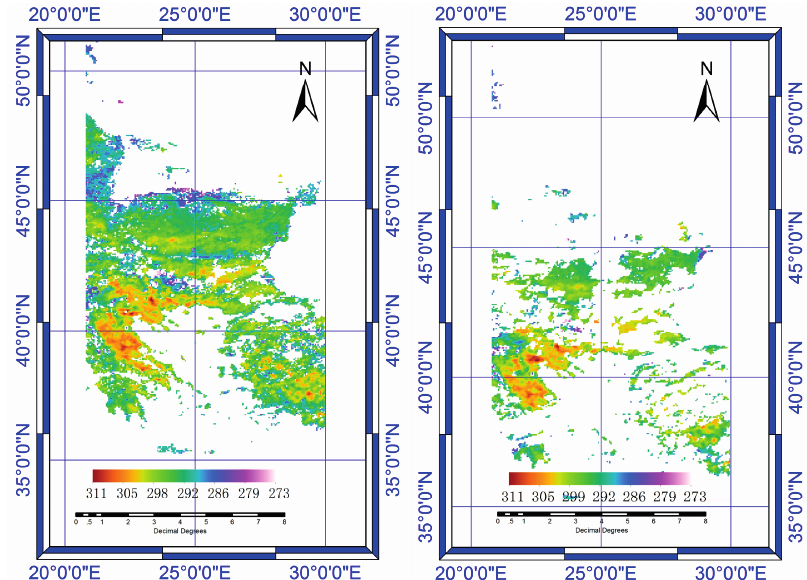
Figure 8. Comparison of LST products from LSASAF, with the LST estimated by the proposed method on 1 April 2012 at 11:00 UTC ( left : estimates from the proposed method; right : the LST